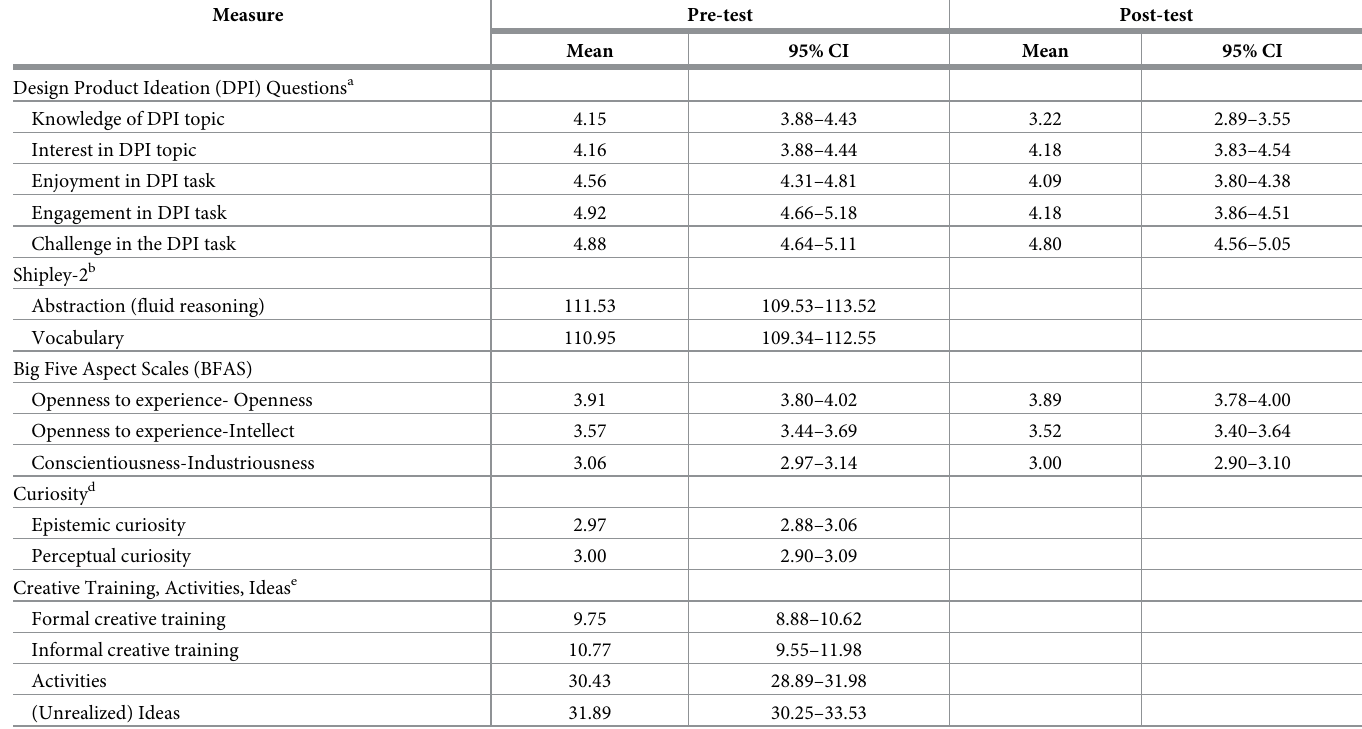
Table 5. Descriptive statistics for the individual difference